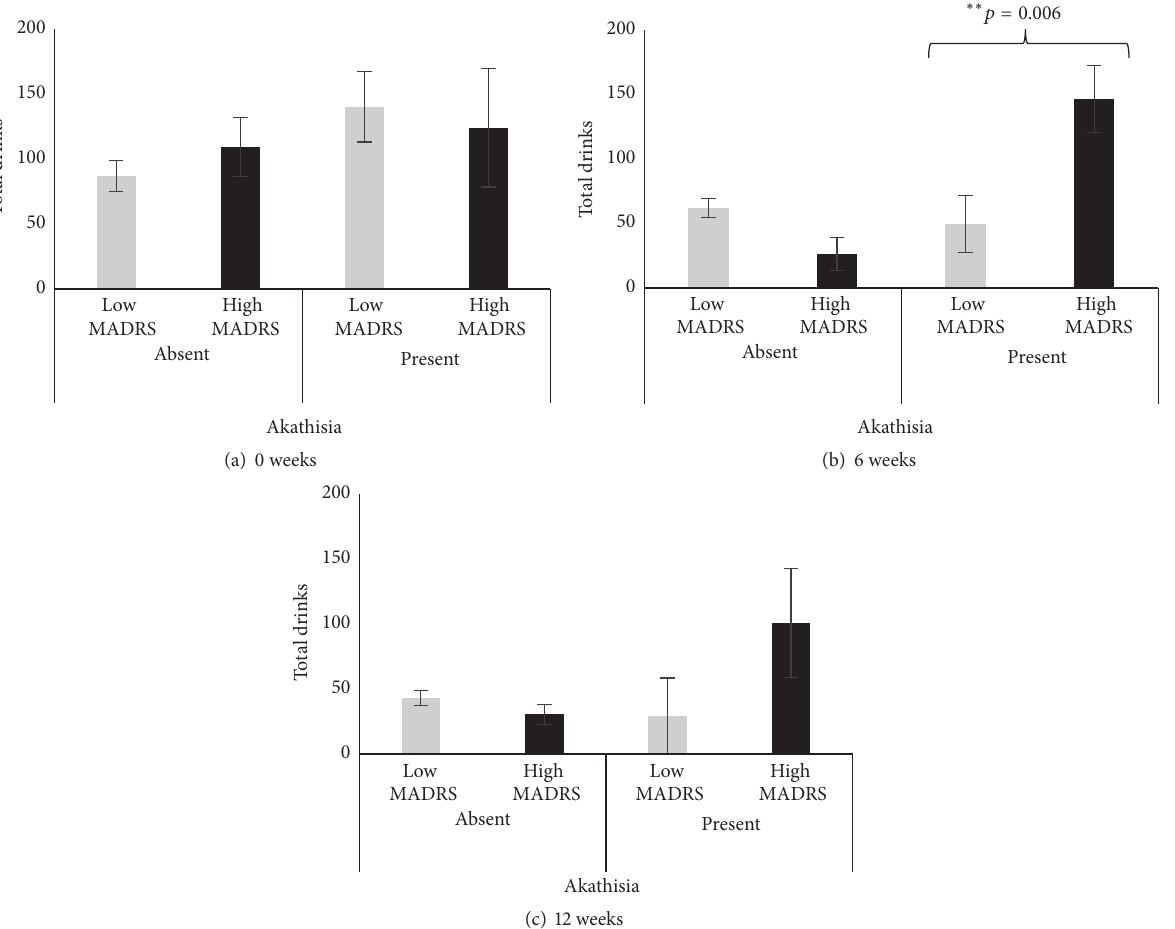
Figure 1: Level of drinking in alcohol dependent patients by MADRS group and reporting of akathisia. (a) Baseline total drinks (TD30) by MADRS and akathisia. (b) Total drinks (TD weeks 4–6) at week 6 by MADRS and akathisia. (c) Total drinks (TD weeks 10–12) at week 12 by MADRS and akathisia. Data presented as M ± SE (mean with standard error). Significance was set at 𝑝 ≤ 0.05